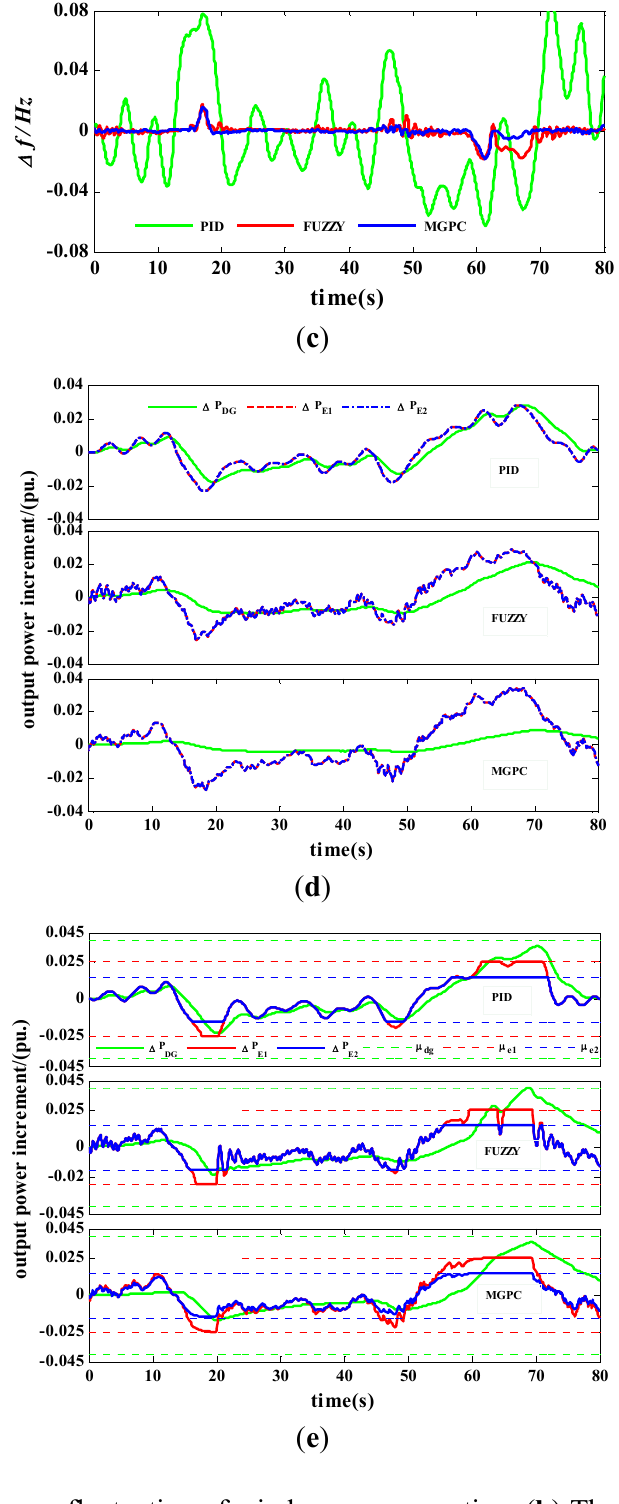
Figure 8. ( a ) The power fluctuation of wind power generation; ( b ) The frequency deviation of the micro-grid without constraints; ( c ) The frequency deviation of the micro-grid with constraints; ( d ) The output power increment of DG, EV1 and EV2 without constraints; ( e ) The output power increment of DG, EV1 and EV2 with